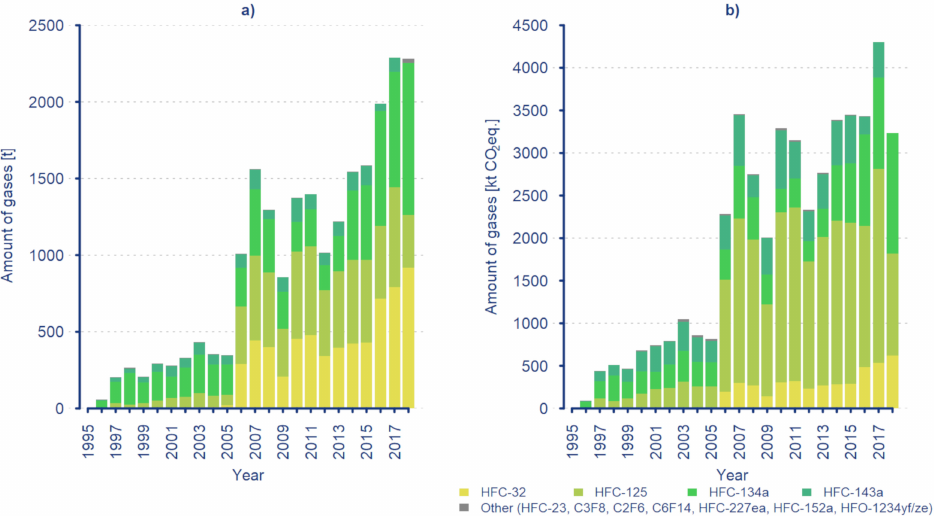
Figure 1. Trend in F-gases used for refrigerants and air conditioning in the Czech Republic in tonnes ( a ) compared to the trend in F-gases recalculated to kt CO 2 eq ( b